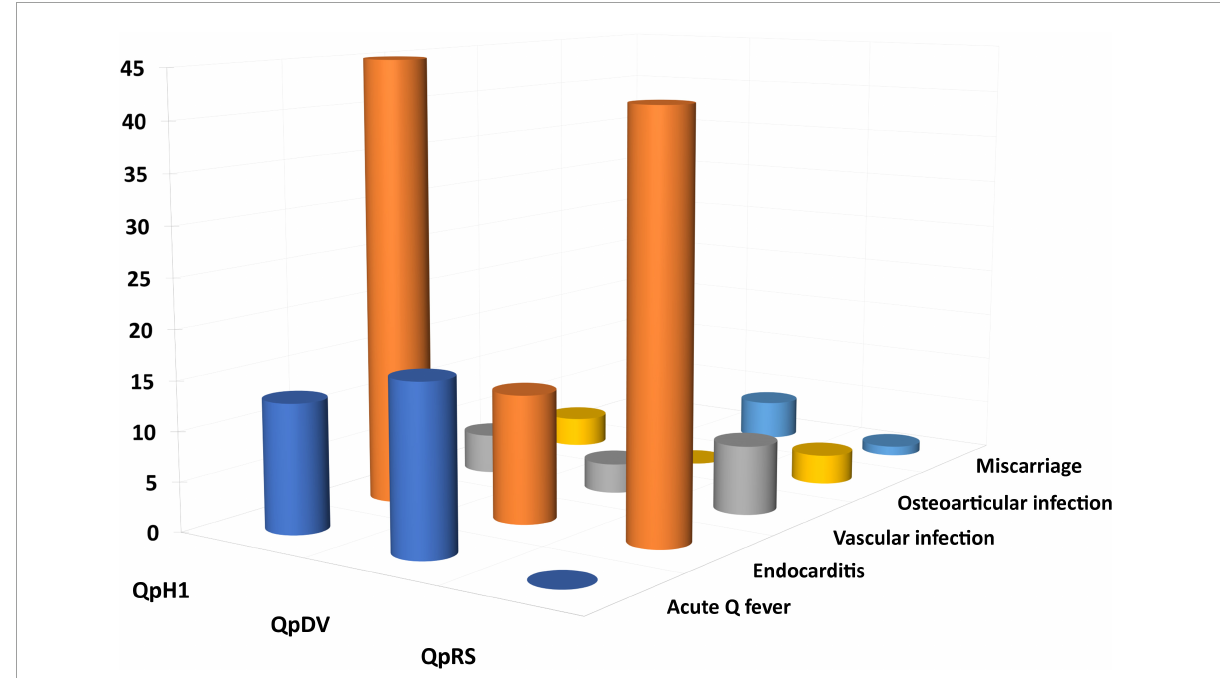
FIGURE7 Distribution between plasmids and clinical presentation.